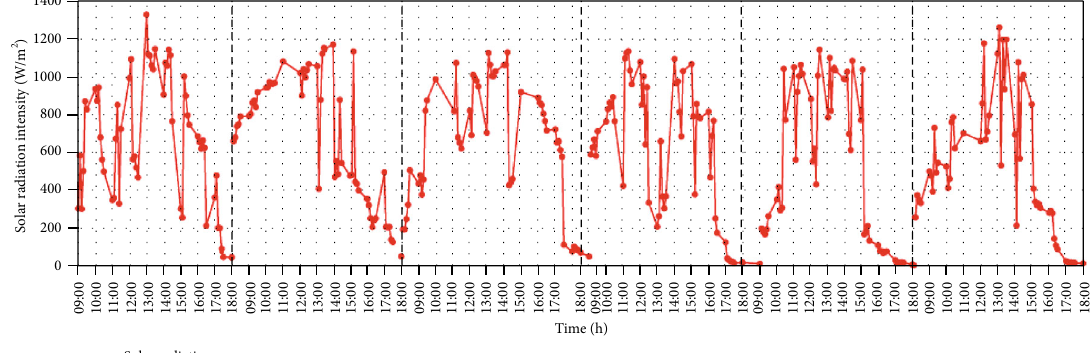
Figure 7: Variation of solar radiation intensity with time during the days of